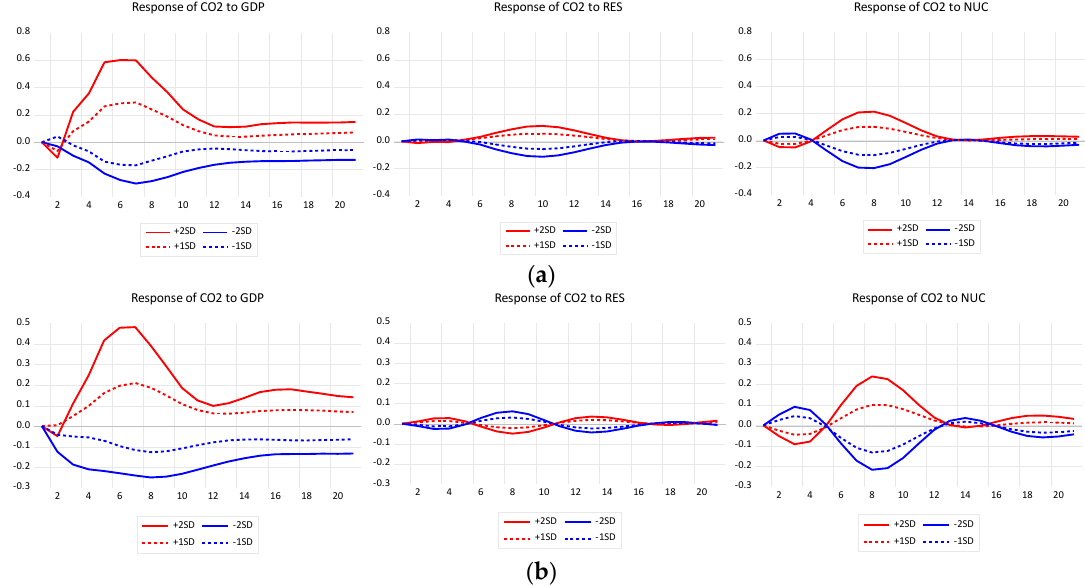
Figure 3. Responses of CO 2 emissions to shocks in GDP, nuclear and renewable energy consumption in ( a ) upper regime; ( b ) lower regime.